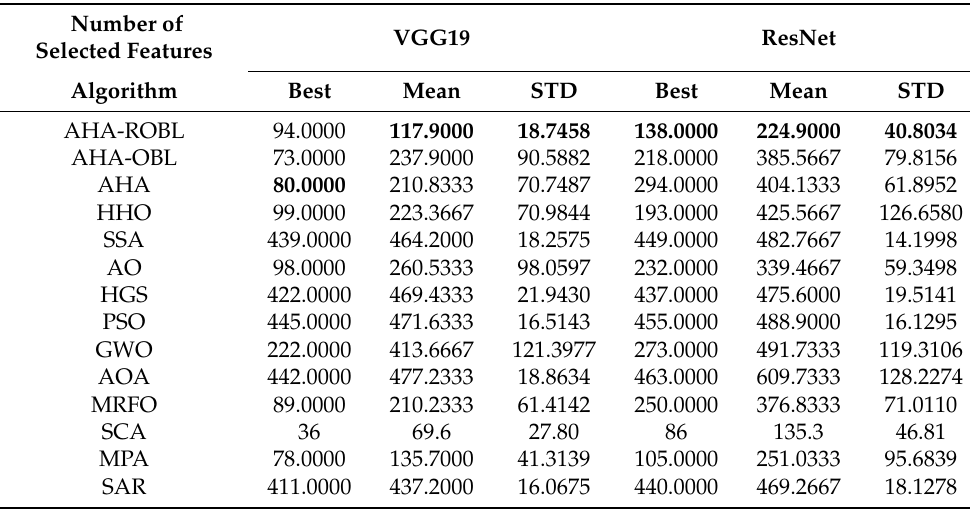
Table 9. Comparison of the performance of deep feature models of the AHA-ROBL with other recent optimizers versus number of selected features.